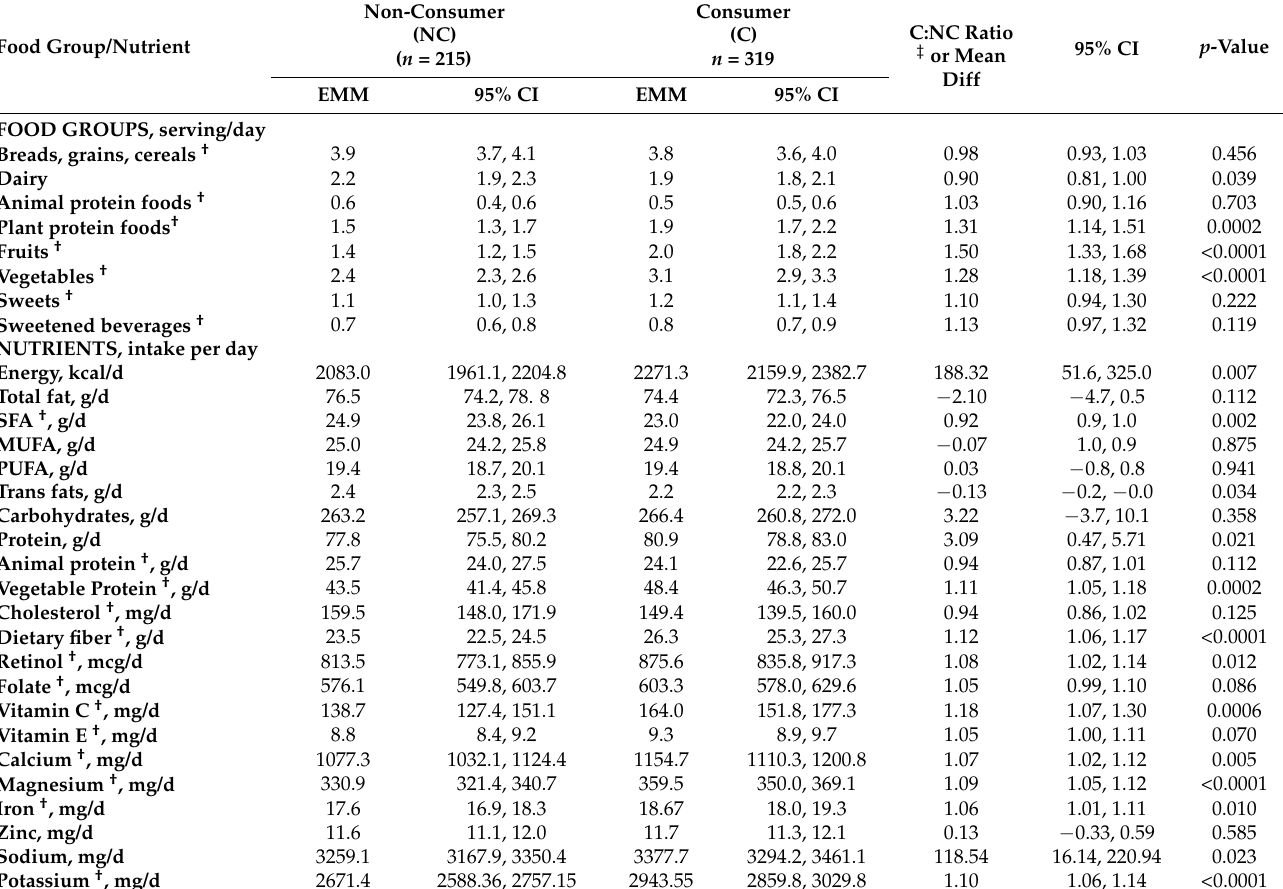
Table 5. Comparison * of intake of selected food groups and nutrients between avocado consumers and non-consumers.